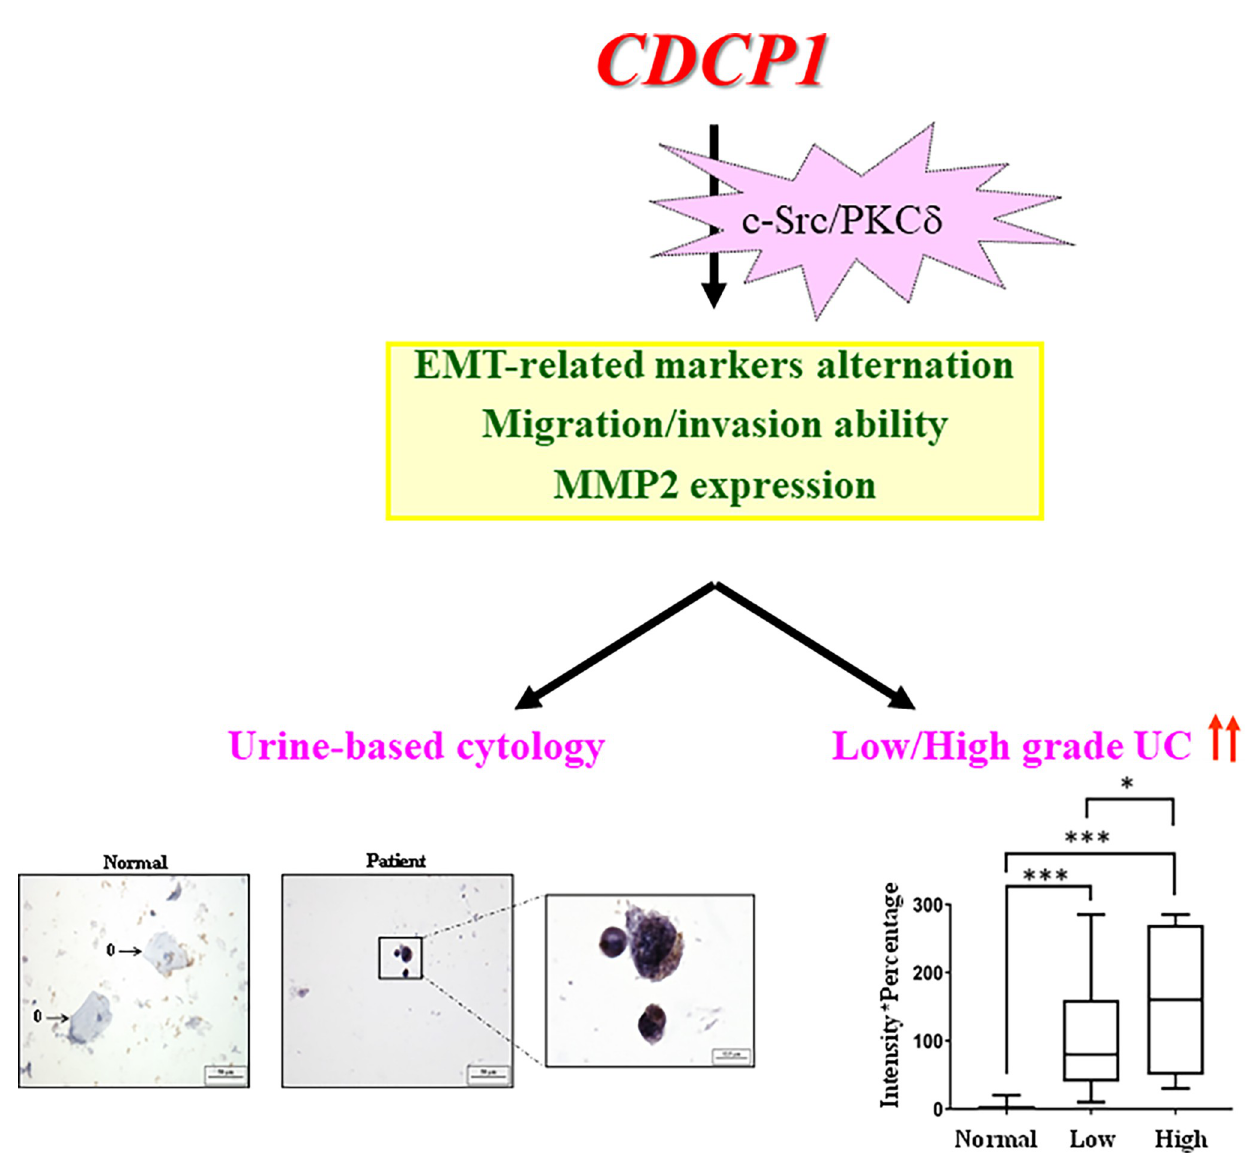
Fig 5. Scheme illustrates the CDCP1 as a promising cytological biomarker for detection of low-grade UC. Urine-based cytology is non-invasive and widely used for clinical diagnosis of UC, but its sensitivity is less than 40% for low-grade UC detection. We found a new biomarker CDCP1, which plays a critical role in the progression of UC and significantly increases in low-grade UC. We suggest CDCP1 may have potential as a urine-based biomarker for detecting low-grade UC in urinary